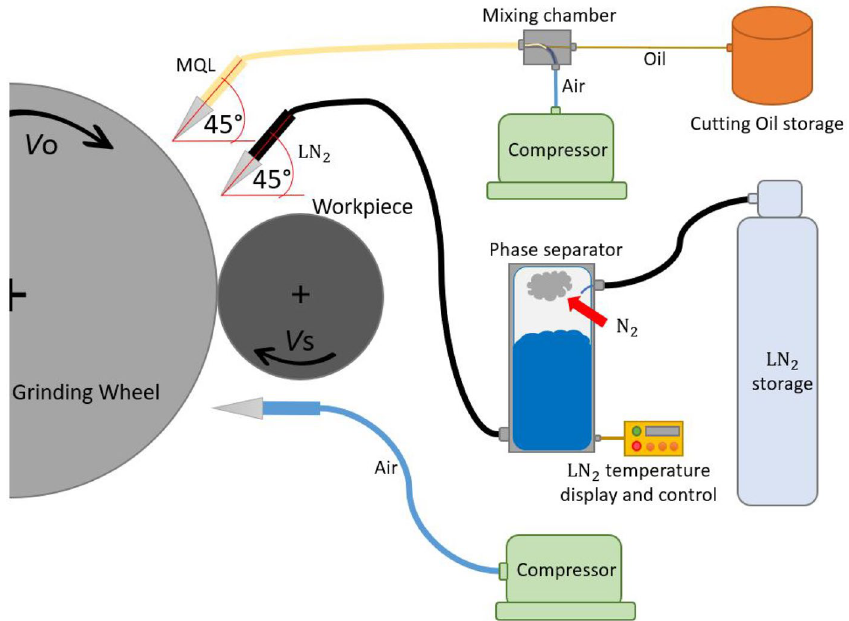
Figure 2. Scheme of the experimental set-up.